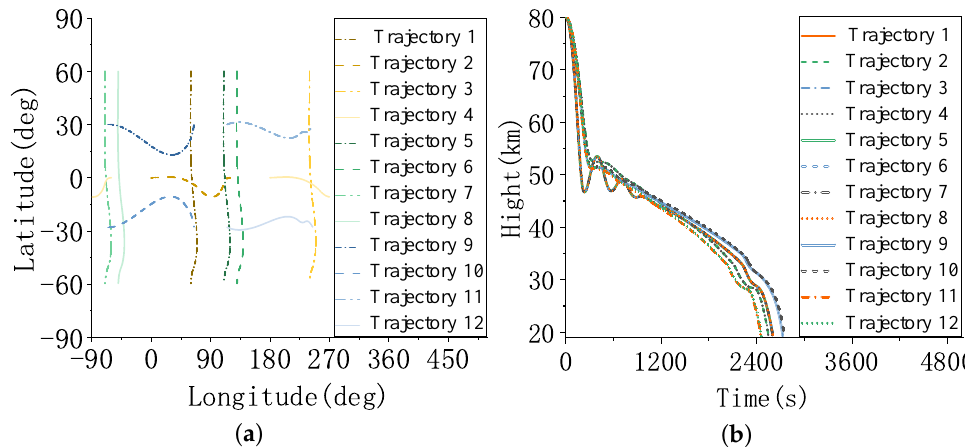
Figure 13. The trajectories of HGVs. ( a ) The latitude and longitude of the trajectories. ( b ) The altitude of the